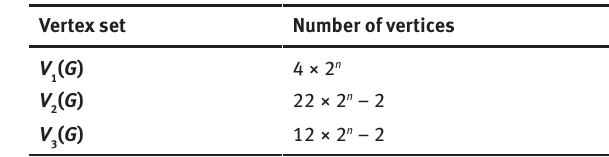
Table 3: Number of vertices in each set of vertex